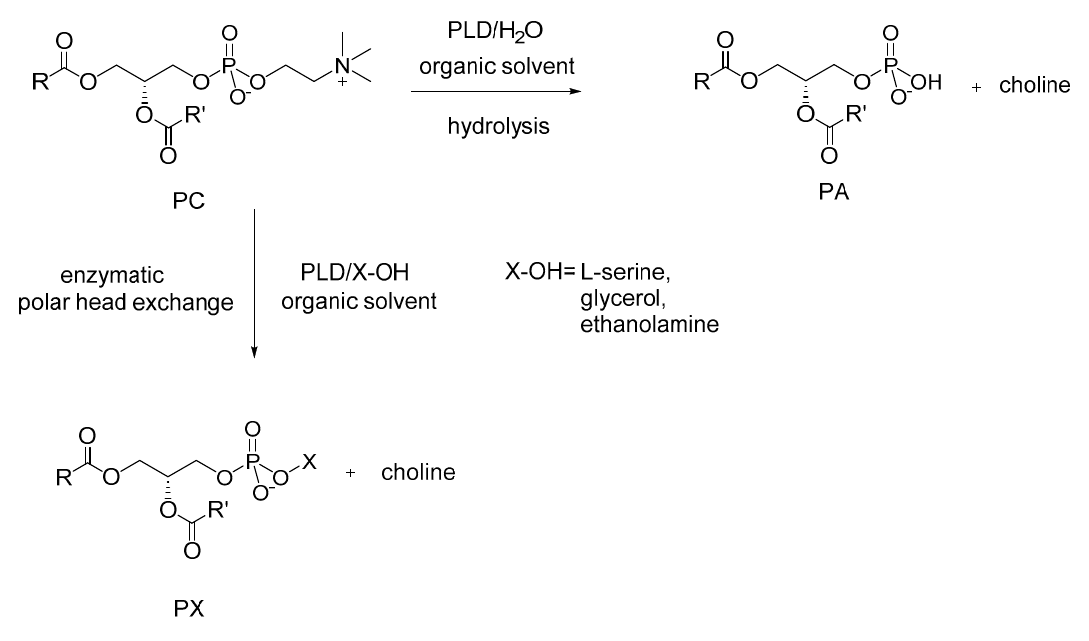
Figure 3. Comparison of 31 P NMR spectra of a standard mixture of PLs (green spectrum) with the BF2-S fraction (red